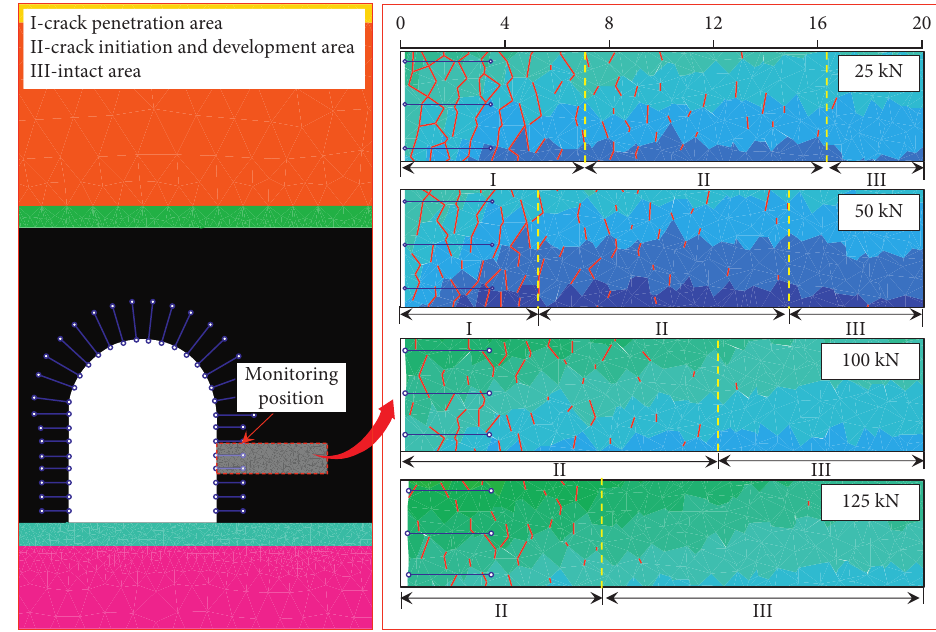
Figure 13: Optimization for the PTF for anchor bolt.